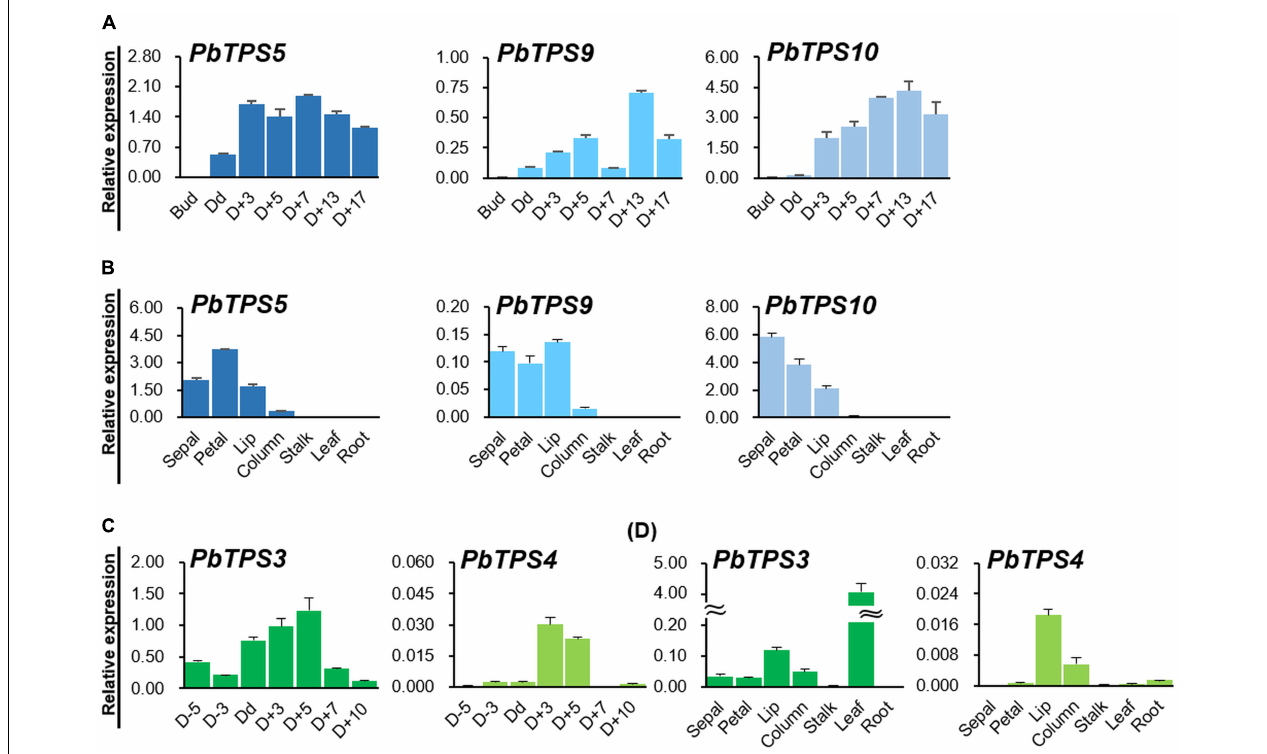
FIGURE 3 | Temporal and spatial gene expression of TPS-b and TPS-e/f members in P. bellina . (A) Temporal and (B) spatial expression profiles of PbTPS5 , PbTPS9 , and PbTPS10. (C) Temporal and (D) spatial expression of PbTPS3 and PbTPS4. Temporal expression of PbTPS5 , PbTPS9 , and PbTPS10 was analyzed at floral bud stage (Bud), day of anthesis (Dd), and 3–17 days after anthesis (D + 3 to D17). Temporal expression of PbTPS3 and PbTPS4 was analyzed from 3 to 5 days before anthesis (D-5 and D-3) and day of anthesis (Dd) to 10 days after anthesis (D + 10) in P. bellina . Spatial gene expression of PbTPS genes was determined in various tissues, including sepal, petal, lip, column, stalk, leaf, and root. Data were obtained from three independent experiments. The expression of all genes was normalized to the reference gene, PbActin1 (Chuang et al., 2018b). Calculation of mean and standard error was based on triplicate